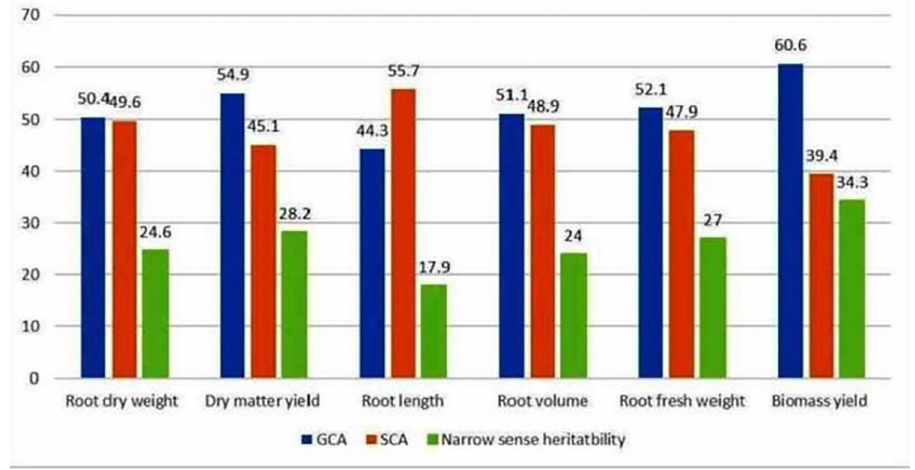
Fig 2. Relative contributions of GCA and SCA, and narrow-sense heritability of the studied biomass yield and root- related traits evaluated under low P conditions in western Ethiopia.